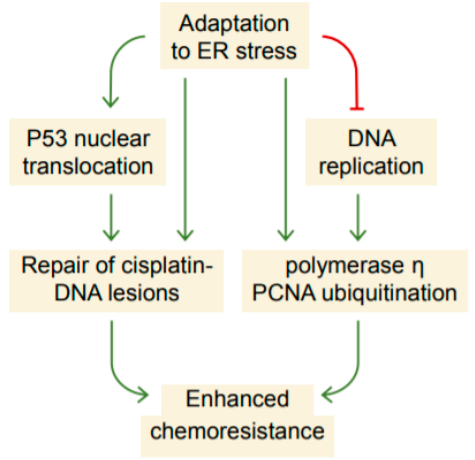
Figure 8. Proposed schematic depicting the enhancement of chemoresistance as a consequence of adaptation to ER stress. The adaptive ER stress response is accompanied by a suppression of DNA replication and cell-cycle progression that, to some extent, resembling the response to replication stress. As a result, cells promote the expression of polymerase η and nuclear translocation of p53, which may possibly increase the efficiency of translesion synthesis and DNA repair, leading to enhanced chemoresistance.